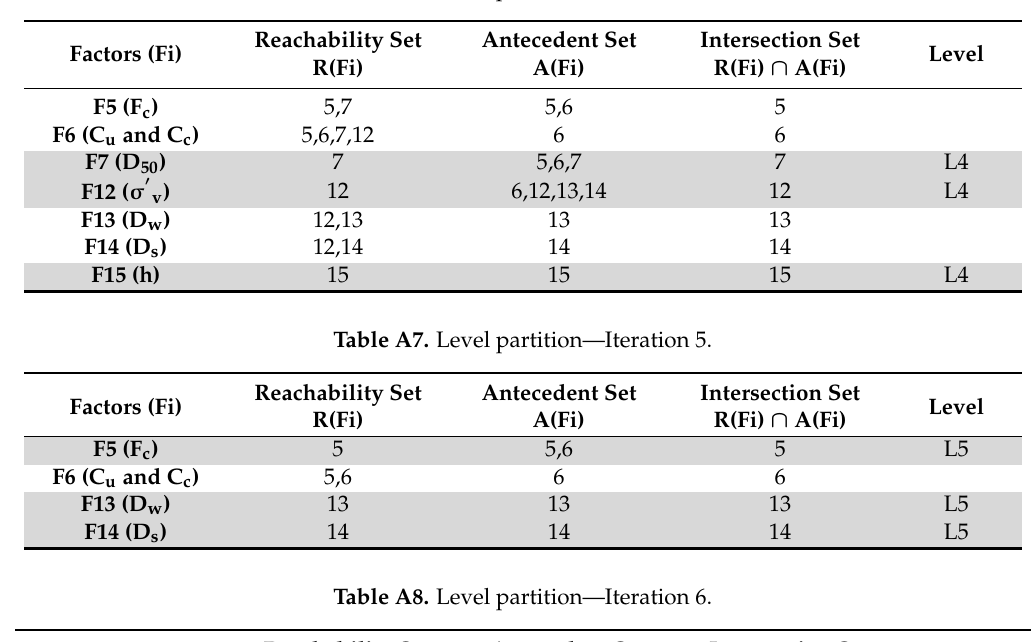
Table A6. Level partition—Iteration 4.